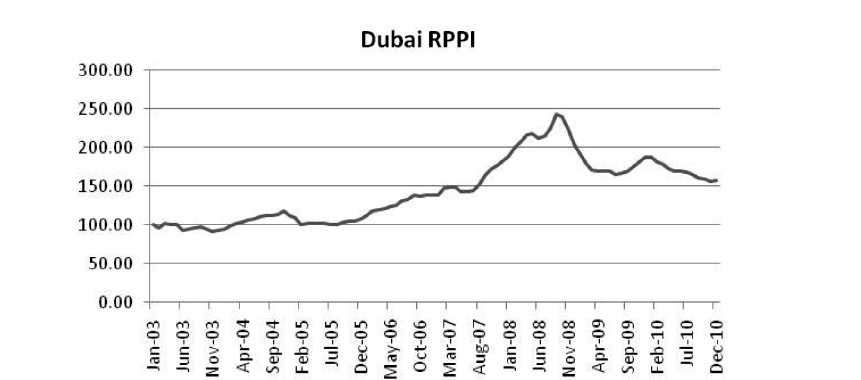
figure 1. reIDIn.com Dubai residential Property Price Index (DrPPI) (January